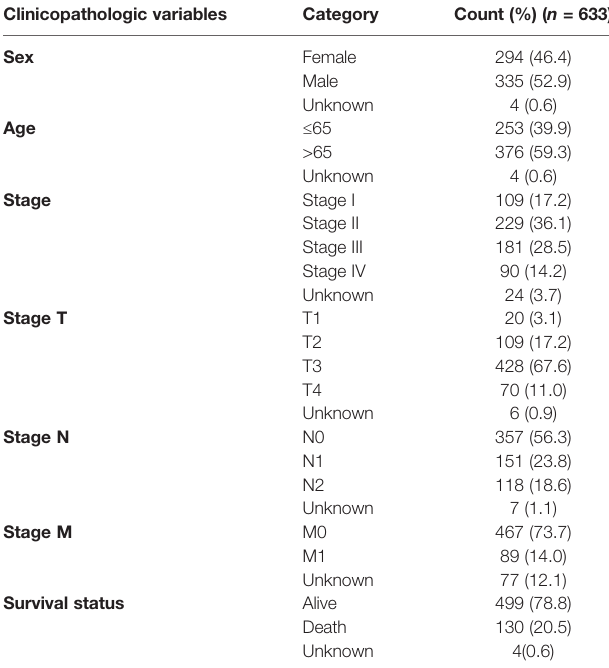
TABLE 1 | Clinical characterizations of